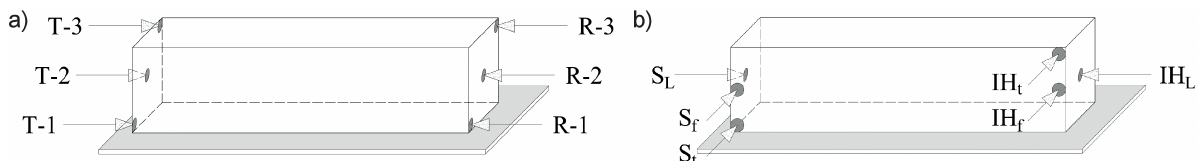
Figure 1. Measurement by the ultrasonic pulse velocity test (T - transmitter, R - receiver); measurement by the resonance method (S - acoustic emission sensor, IH - impact hammer).